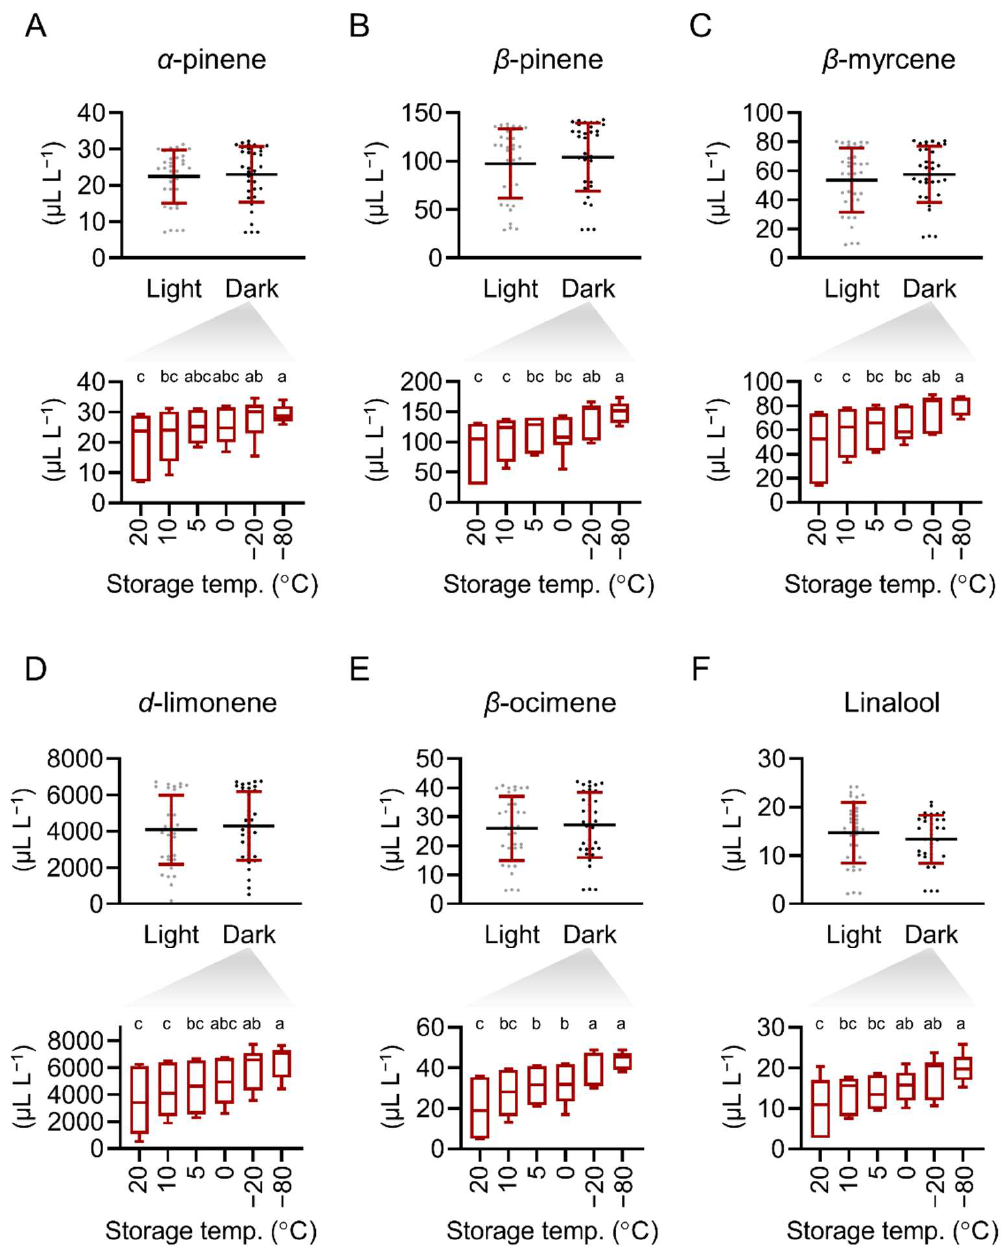
Figure 4. Storage light and temperature conditions affect the retention of ( A ) α -pinene, ( B ) β -pinene, ( C ) β -myrcene, ( D ) d -limonene, ( E ) β -ocimene, and ( F ) linalool in PE. Top panels: data are presented as mean ± SD with individual values presented in dots. Bottom panels: box and whisker plots showing minimum, first quartile, median, third quartile, and maximum values of the data. Significant differences are indicated by different alphabets (Tukey’s tests, p < 0.05; top panels: n = 36; bottom panels: n = 9).